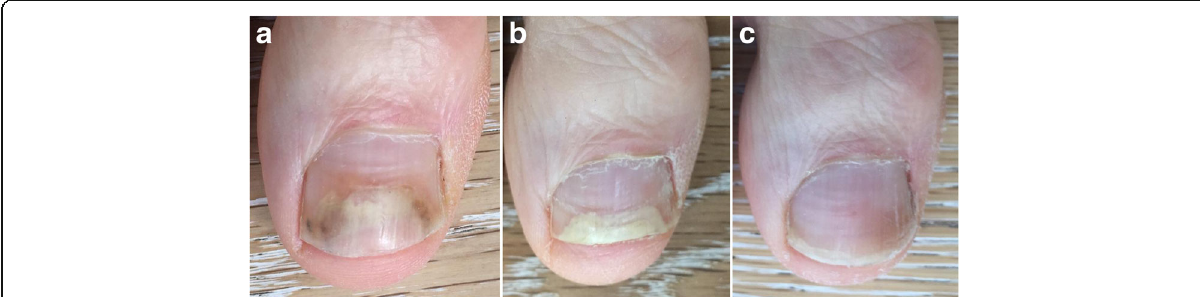
Fig. 6 Case 2: Calmagen® lotion cleared onychomycosis in a 50+ year-old Caucasian male who had the condition for 10 years and tried different treatments including oral terbinafine which failed. Before treatment ( a ); 1.5 months after treatment ( b ); 14 months after treatment and 11 months after stopping treatment ( c